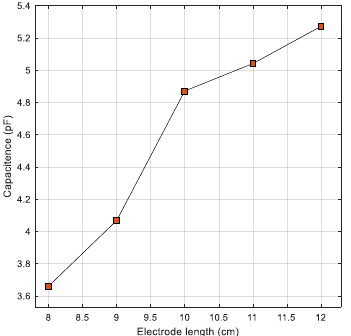
Figure 6. Diagram of relationship between sensor capacity and electrode length.